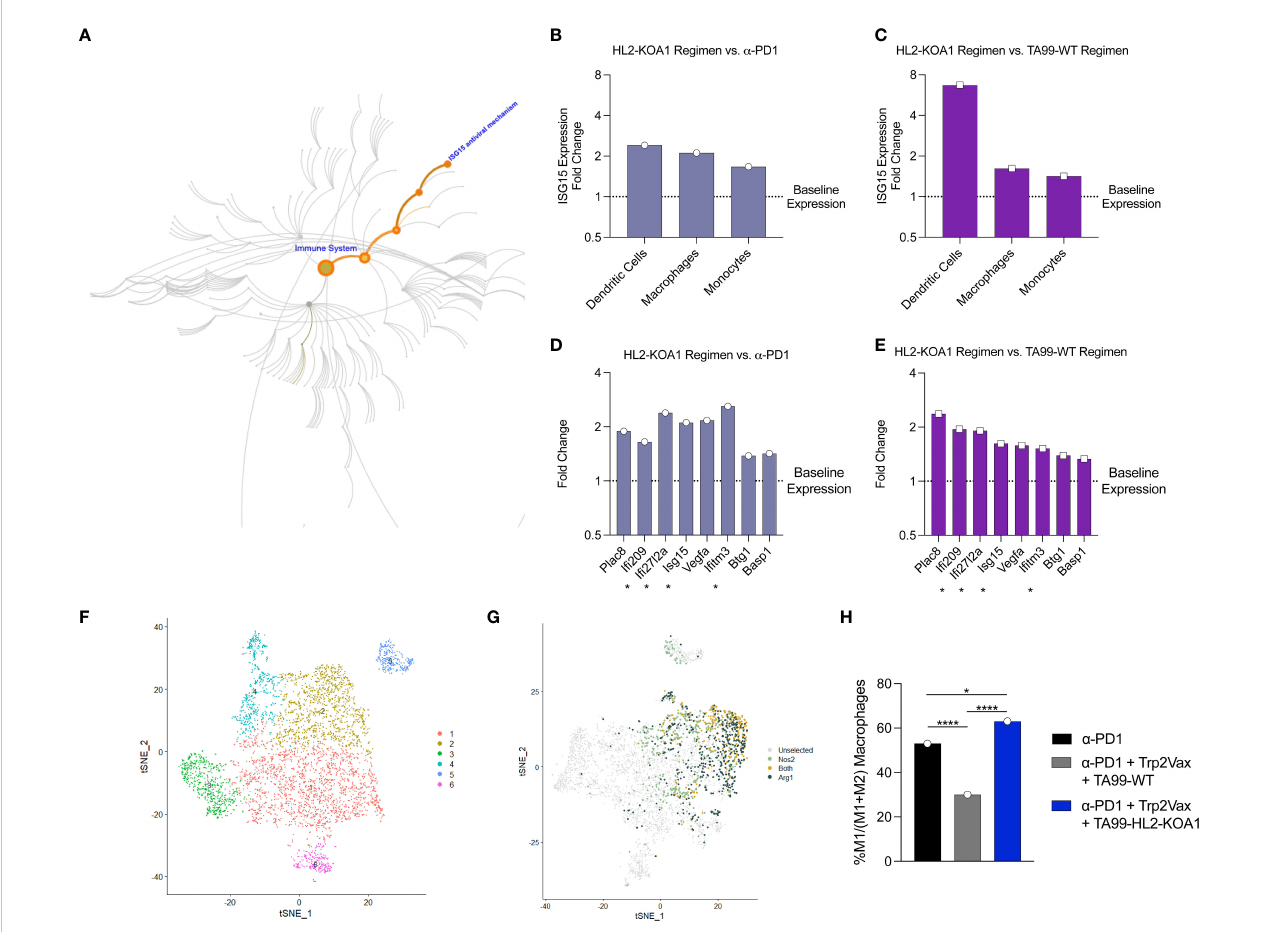
FIGURE 4 Transcriptomic analyses demonstrated upregulation of Type I interferon responses following TA99-HL2-KOA1 treatment. (A) Map of ISG15 as part of the Type I interferon responsive elements in pathway analysis. (B, C) Fold changes in ISG15 in intratumoral DCs, macrophages and monocytes in mice treated with anti-PD1+ Trp2Vax + TA99-HL2-KOA1 versus corresponding cell types from mice treated with only anti-PD1 (B) or with anti-PD1+ Trp2Vax + TA99-WT (C) . (D, E) Fold changes of the most upregulated genes in the intratumoral macrophages of mice treated with anti-PD1+ Trp2Vax + TA99-HL2-KOA1 versus intratumoral macrophages from mice treated with only anti-PD1 (D) or with anti-PD1+ Trp2Vax + TA99-WT (E) . Asterisk * marks IFN-responsive genes. (F) Re-clustering of cells as in Figure 3E based on canonical macrophage markers. (G) Nos2 and Arg1 expression clustering based on (F) . (H) Percent M1 macrophages in each treatment group relative to the total of M1 and M2 macrophages. N=5 mice/group were pooled for transcriptomic analyses in this Figure. *p=0.021, ****p=10 -7 (PD-1 vs. TA99 Regimen), ****p<10 -10 (TA99 Regimen vs. HL2-KOA1 Regimen) by Fisher Exact Test. Each dot represents a pool of 5 animals receiving the same